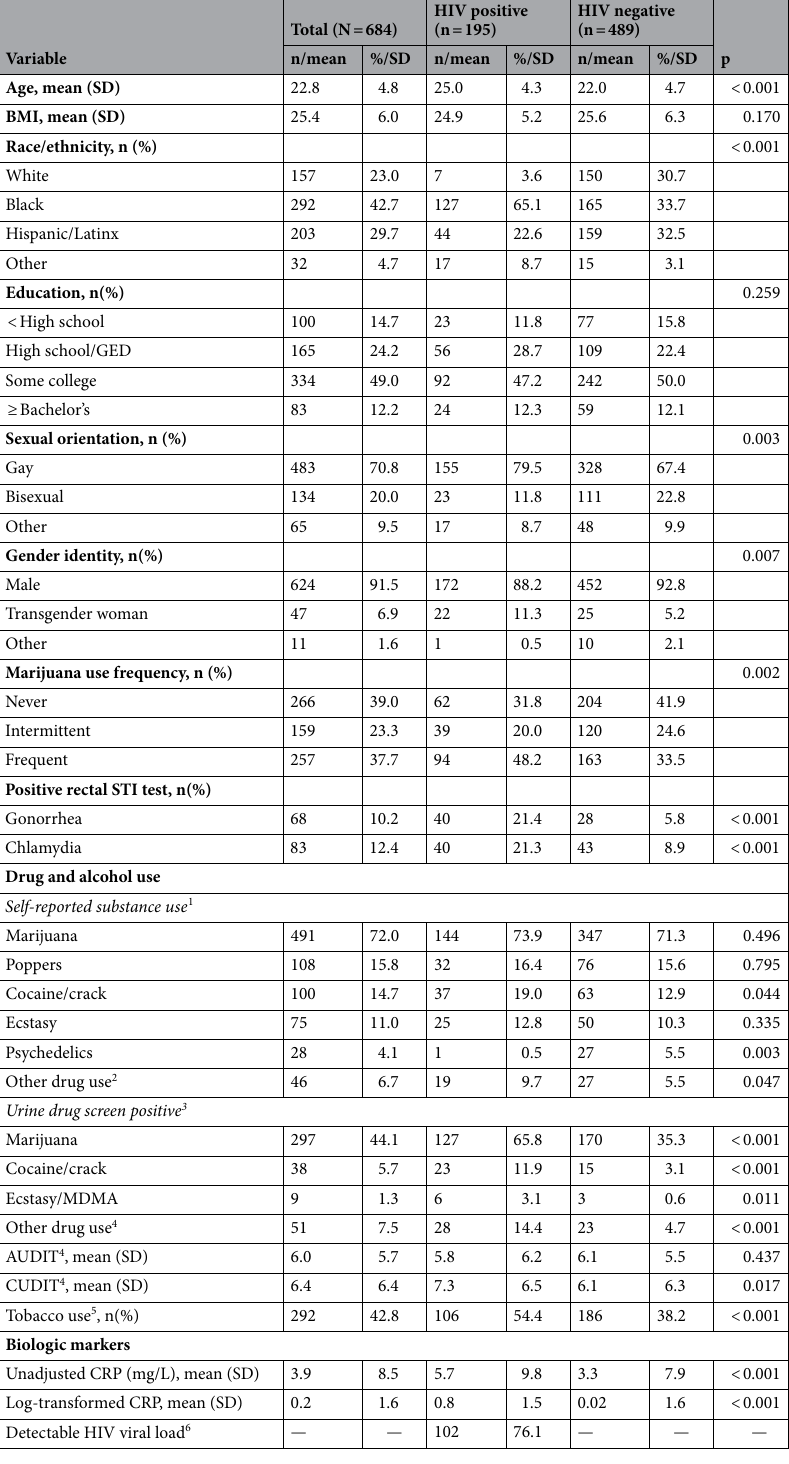
Table 1. Demographic characteristics, stratified by HIV status, RADAR, Chicago 2015–2017. BMI = body mass index; STI = sexually transmitted infection; CRP = C-reactive protein. 1 In the past six months. 2 Other drug use includes: methamphetamines, synthetic marijuana, ketamine, GHB, inhalants, heroin. 3 Note: urine drug screens unavailable for poppers and psychedelics; other urine drug screen includes: benzodiazepines, amphetamines, methamphetamines, opiates. 4 Based on the Alcohol Use Disorders Identification Test (AUDIT) and Cannabis Use Disorders Identification Test (CUDIT) scoring methods; higher score indicates higher risk alcohol use. 5 In the past 30 days. 6 Detectable viral load defined as ≥ 50 copies/mL; viral load data available on 134 participants